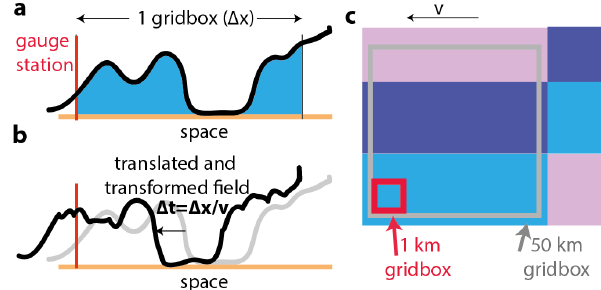
Figure 6. Schematic illustration of the Taylor hypothesis. (a) One- dimensional case showing space, grid box width and precipitation intensity (black curve); the location of a gauge station is marked in red. (b) Similar to (a) but illustrating how the curve may change due to small-scale dynamics after a time interval (cid:49)t = (cid:49)x/v , with v the atmospheric advection velocity. (c) Two-dimensional inhomo- geneities (different colors indicate different intensities) perpendicu- lar to the advection direction (direction indicated by the thin arrow). Small (red) and large (gray) grid boxes as